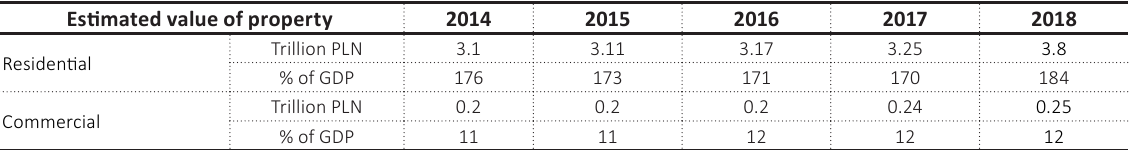
Source: Own study based on NBP data.